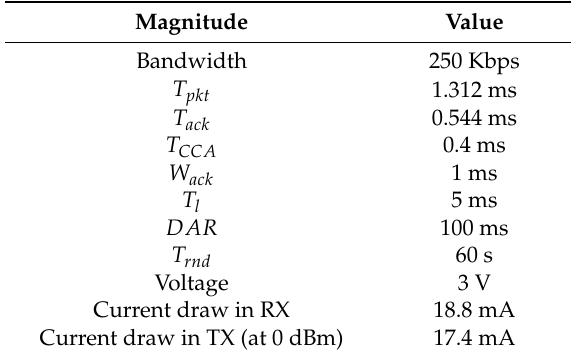
Figure 3. Relative error between exact and approximate energy consumption models for TinyOS sensor nodes. Table 1. Parameters used in the validation of the approximate energy consumption model for LPL TinyOS nodes. RX and TX denote, respectively, the reception and transmission modes of